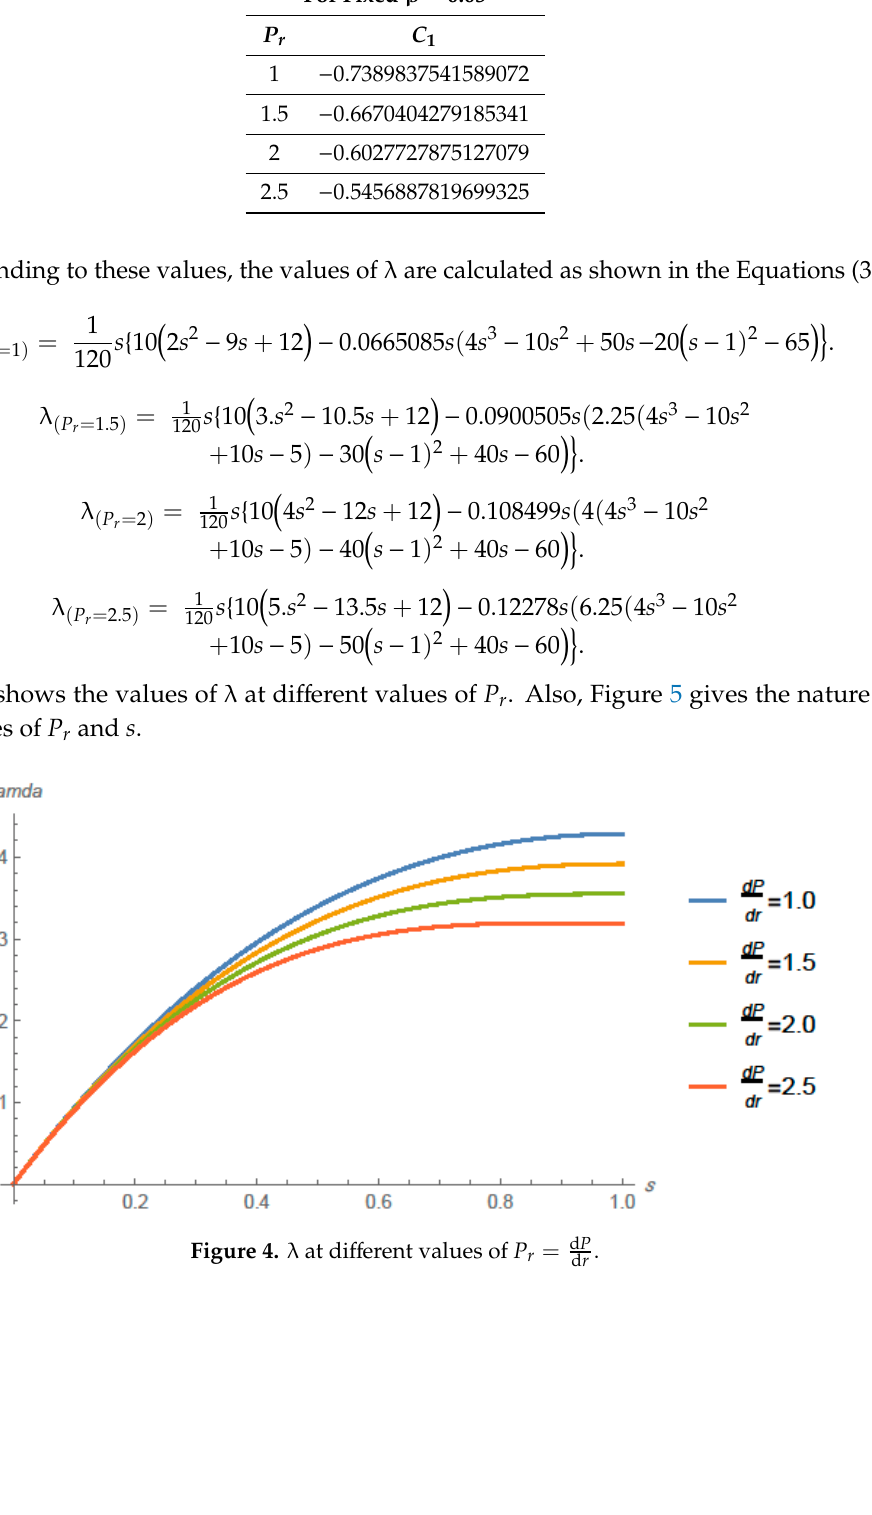
Figure 4. λ at di ff erent values of P r = d P Figure 4. λ at different values of 𝑃 (cid:3045) = (cid:2914)(cid:3017)